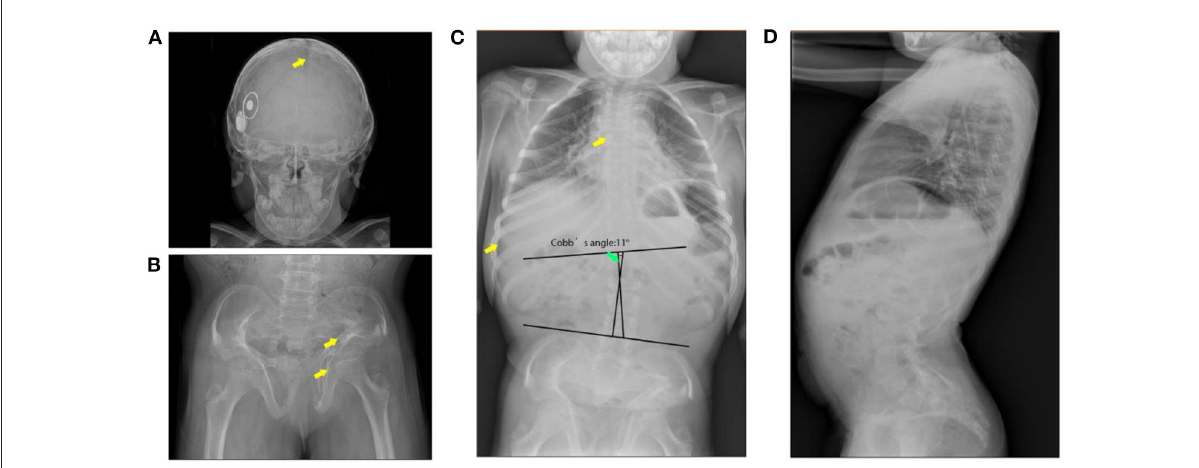
FIGURE1 X-ray images of the patient. (A) Broad skull with open suture and wormain bones (indicates with the arrow). (B) Malformation of the pelvis (indicates with the arrow), low bone density, wide and flat acetabulum (indicates with the arrow), and increased angle of the femoral neck stem. (C) Flattened spinal vertebrae (indicates with arrow), thin ribs, and scoliosis. (D) Pronounced anterior lumbar